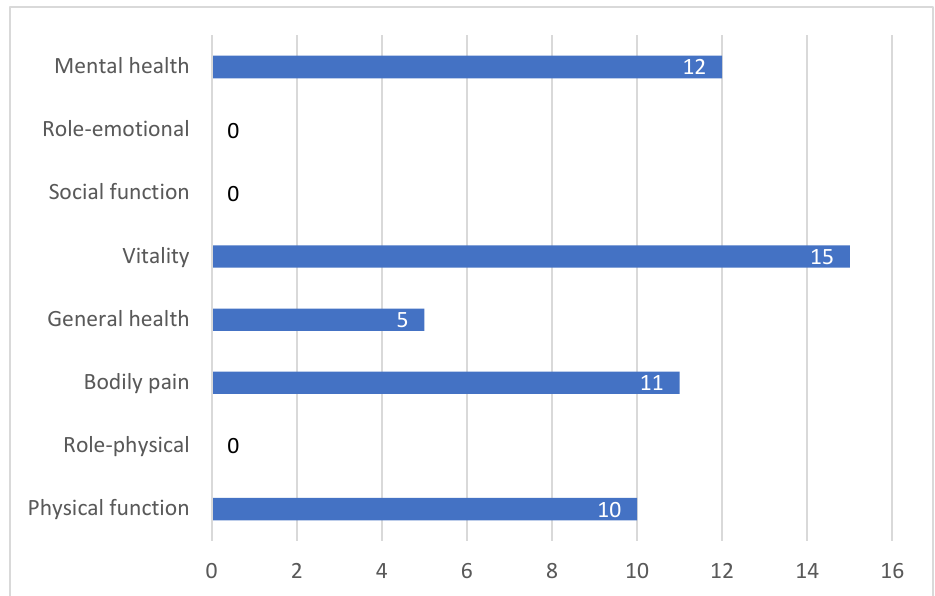
Figure 2. SF-36 domain median variations from baseline to 3 months of physical activity. Alhashemi A et al. (2017) investigated the severity and prevalence of moderate and severe fatigue in thyroid cancer survivors. The study explored the effect of physical activity on potential predictive factors [23]. More than half of the respondents (52.5%; the authors provide sex-stratified data) reported feeling unusually fatigued within the previous week. The mean brief fatigue inventory (BFI) global fatigue score was 3.5 ± 2.4 (95% CI: 3.2–3.8) out of 10 (10 is worst), and the prevalence of moderate–severe fatigue (global BFI score: 4.1–10 out of 10) was 41.4% (84/203). All 205 (152 women) participants provided